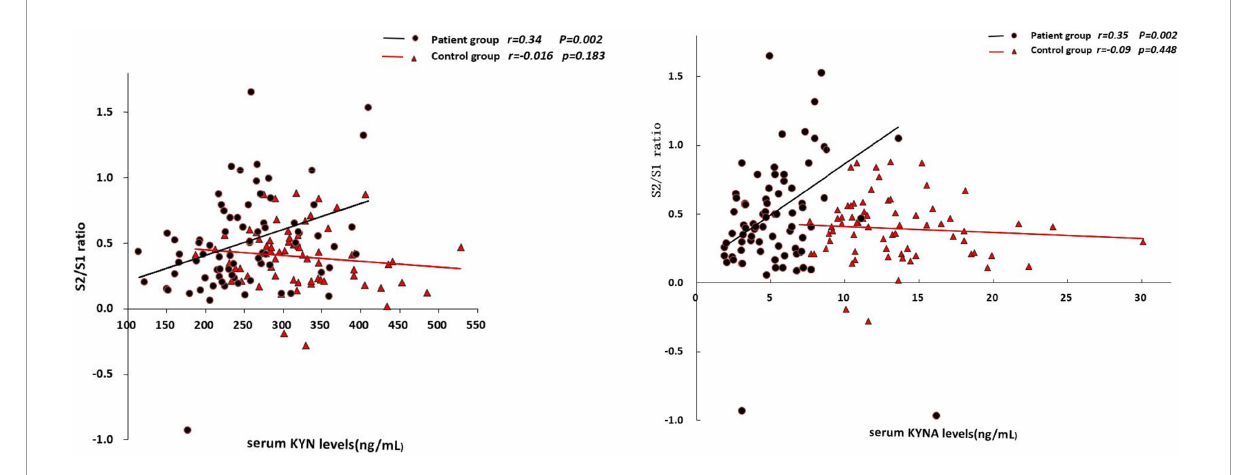
FIGURE1 Correlations between S2/S1 ratio and the serum levels of KYN and KYNA, respectively.